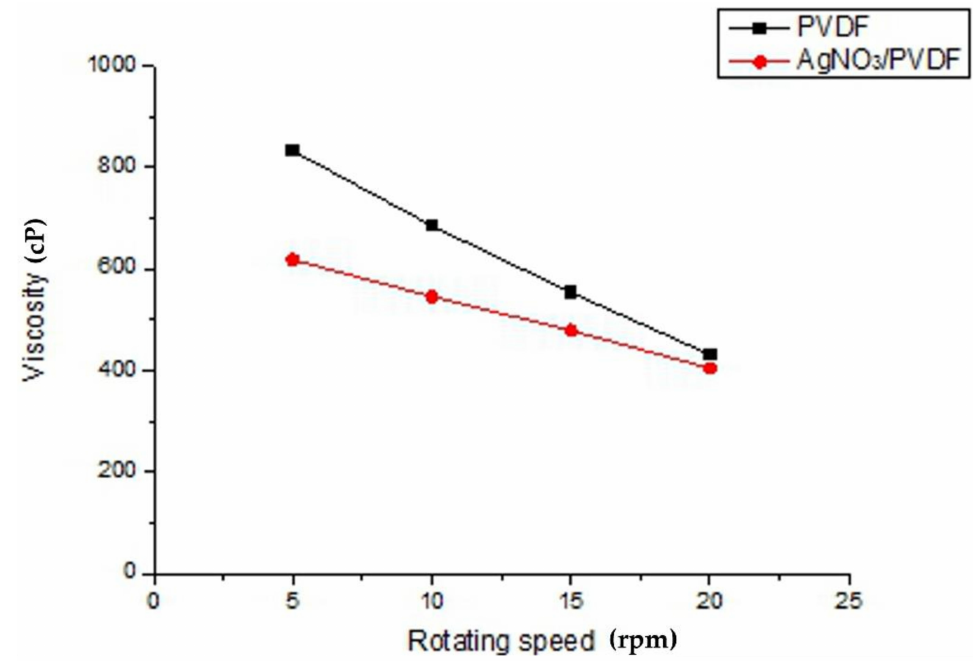
Figure 5. Analysis of solution viscosity characteristics of electrospinning.